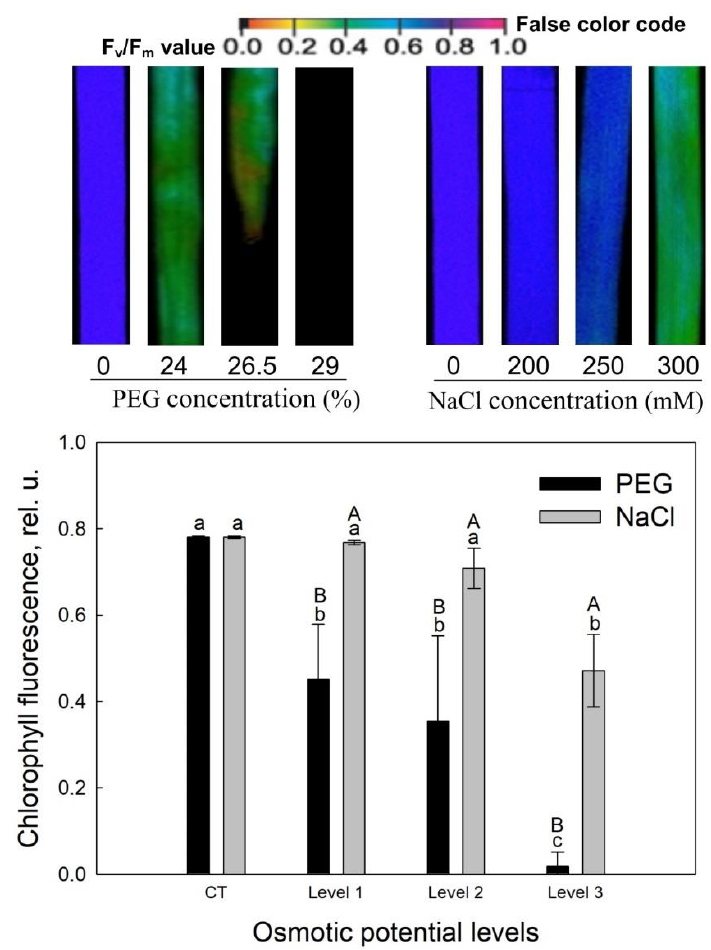
Figure 2. Images and the mean ± SD (n = 3) of the maximum quantum yield of photosynthetic system II (F v / F m ) of leaves collected from seedlings grown under three iso-osmotic potential levels under separate PEG and NaCl treatments. Level 1: 24% ( w / v ) PEG and 200 mM NaCl; Level 2: 26.5% ( w / v ) PEG and 250 mM NaCl; Level 3: 29% ( w / v ) PEG and 300 mM NaCl. Means with di ff erent lowercase letters significantly di ff er in an LSD test under di ff erent PEG or NaCl concentrations, respectively ( p < 0.05). Means with di ff erent capital letters significantly di ff er in a t -test between PEG and NaCl concentration at the same osmotic potential level. The false color code depicted on the top of the images ranges from 0.0 (black) to 1.0 (purple).